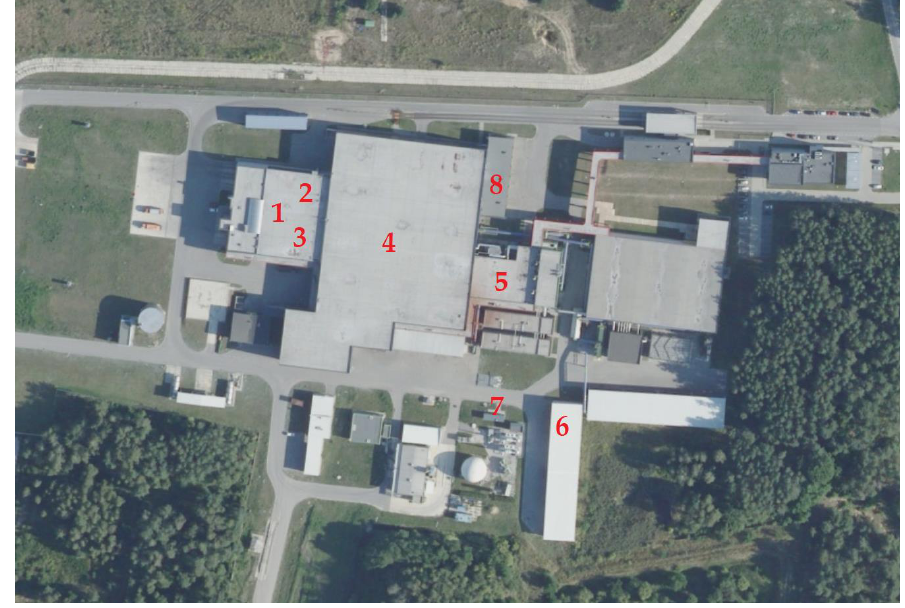
Figure 2. Measurement points locations at biogas plant in Promnik.